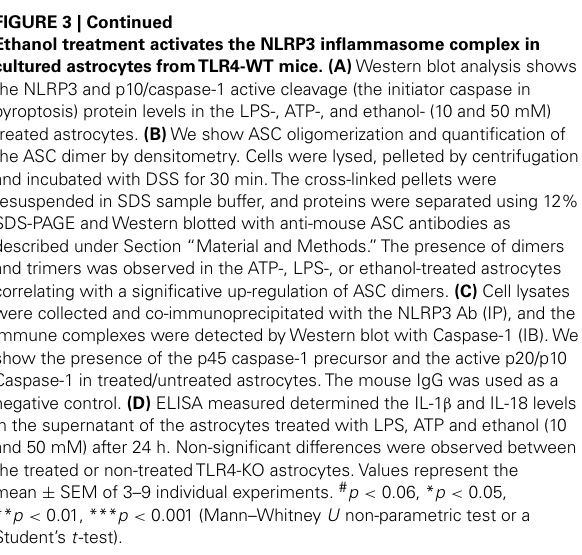
Caspase-1 in treated/untreated astrocytes.The mouse IgG was used as a negative control. (D) ELISA measured determined the IL-1 β and IL-18